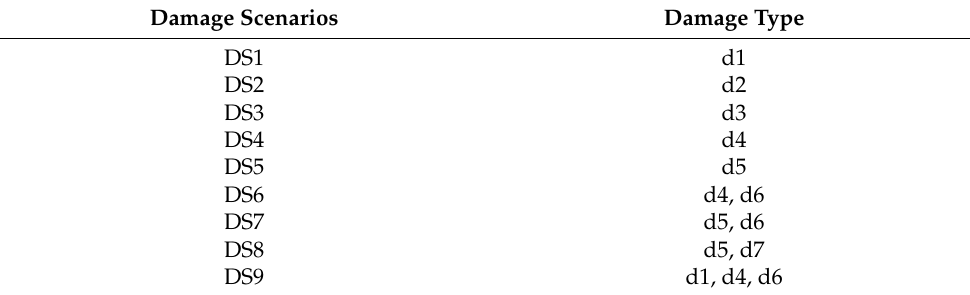
Table 1. Simulated damage scenarios.